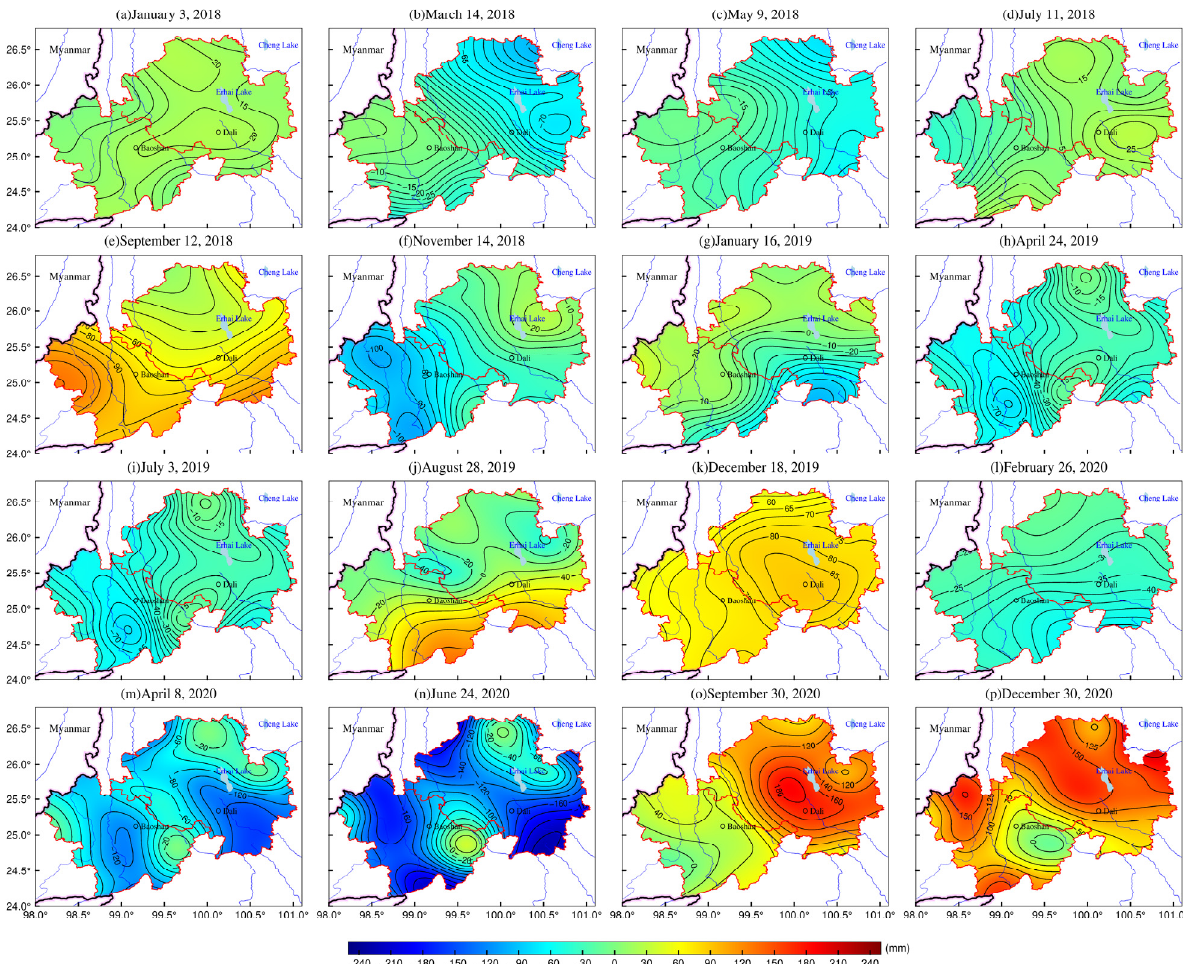
Figure 7. Weekly GWSA over the January 2018-December 2020 period. The errors generated from the GNSS data processing, the surface mass model, and the uncertainty in the CORS inversion model may affect the accuracy of the GWSA inversion. The inverse distance weight interpolation method was used in this study to map the time series of the GWSA of CORS stations. Table 5 shows the statistical results of the interpolated GWSA time series of 12 CORS stations. The maximum and minimum values of the inverted GWSA were − 200 and 200 mm, respectively. In addition, there were some differences in the amplitude variation of GWSA at different CORS stations, indicating that the CORS inverse results had a high resolution. The mean and standard deviation (SD) values of GWSA at all CORS stations ranged from 3.16 to 15.03 mm and 55.87 to 110.39 mm, respectively. The reliability of the CORS inverse results was assessed in the subsequent part using the GRACE inverse results and groundwater monitoring station data. Table 5. Statistics of CORS inverse results for GWSA (mm). Max